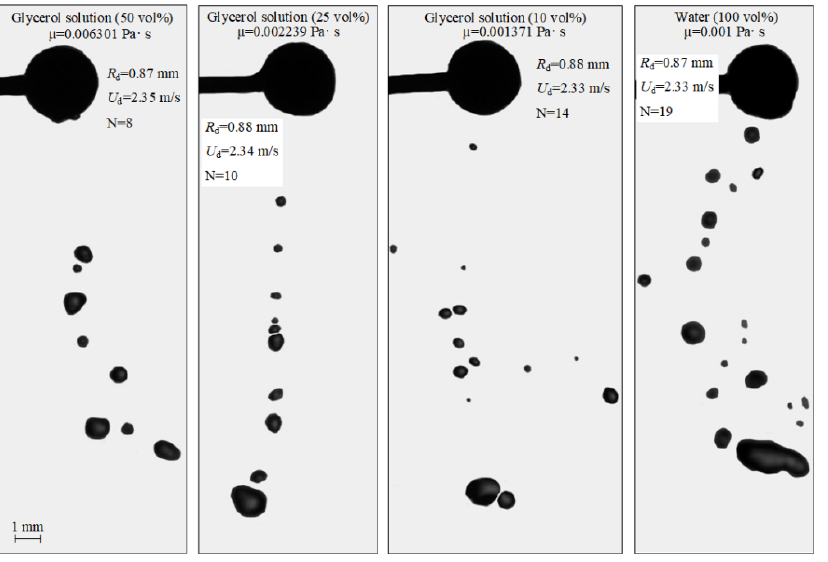
Figure 4. Images illustrating the collisions of water droplets with a particle in the stretching separation regime at varying liquid viscosities.